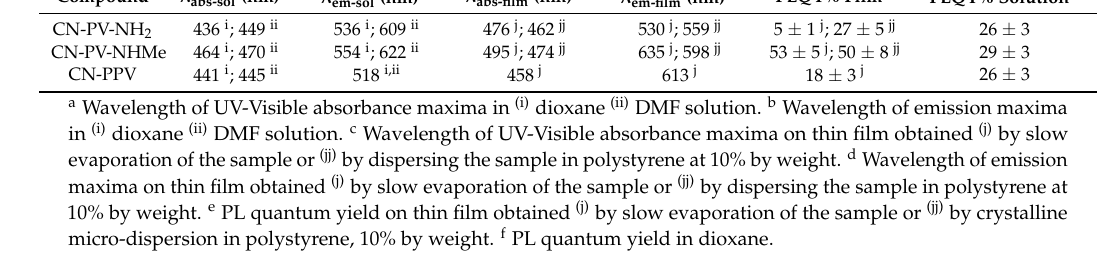
Table 1. Optical data of synthesized compounds.